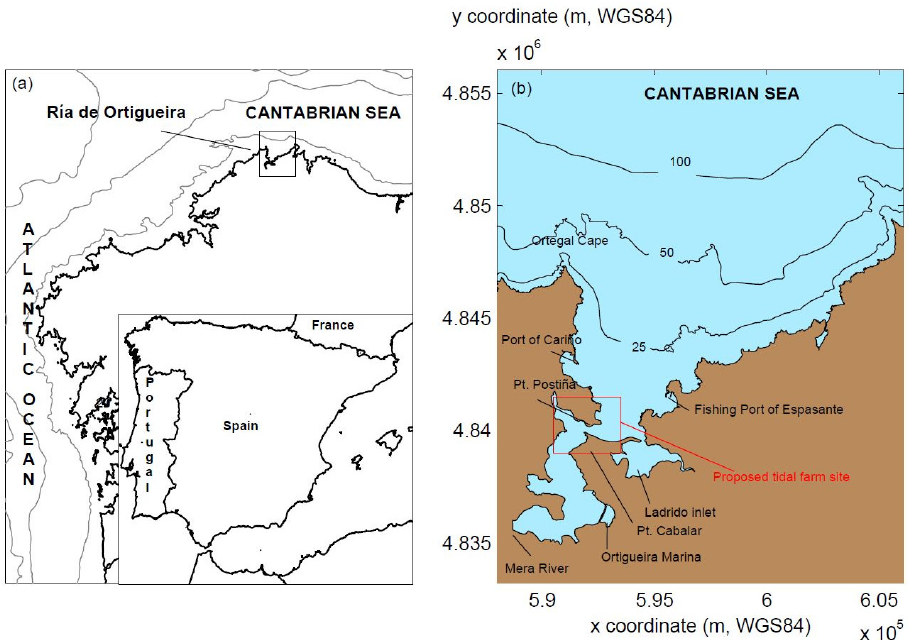
Figure 1. The Ria de Ortigueira ( b ) and its location in Galicia (NW Spain) ( a ).